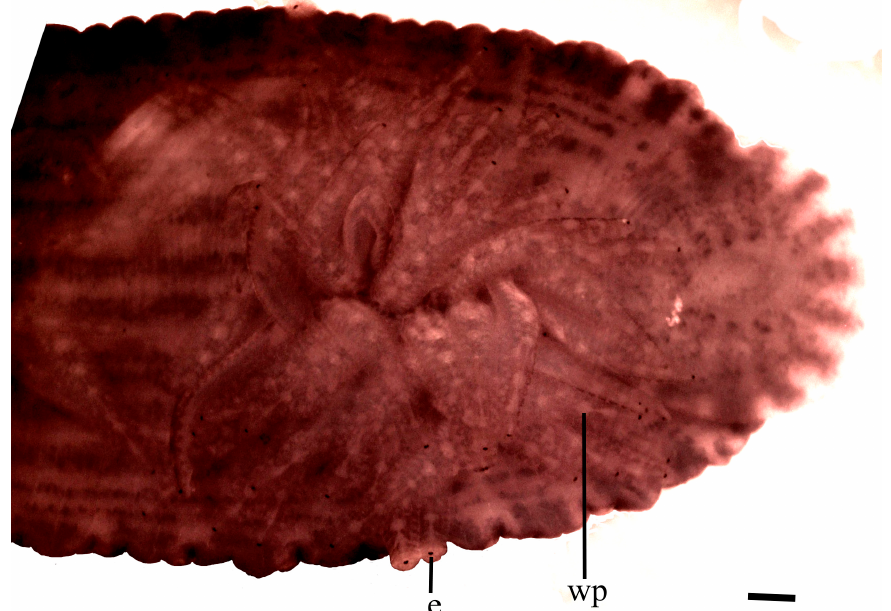
Figure 10. Recent hatchlings of P. parasitica from the Outer Banks more closely resemble adults of P. multilineata [9] (fig. 6A) than adults of their own species (Figure 1A). Shown are numerous hatchlings (PP-4b) brooded on the venter of the parent (PP-4a). Note each hatchling displays six discrete mid-dorsal white patches (see also Figures 11 and 12) barely recognisable in the adult (but see Figure 2C). Abbreviations: e, eye of hatchling; wp, white patch of hatchling. Scale bar: 1.0 mm. Tubercle obfuscation in P. parasitica versus prominence in P. multilineata . Of consid ‐ erable morphological significance, hatchlings of P. parasitica differ from adults in having small but distinct dorsal tubercles (Figure 11, tu). These are in longitudinal rows in inter ‐ mediate position on the a2 annulus in segments XIII–XXII, inclusively (Figure 12, tu). Fur ‐ thermore, these align near the respective tips of the underlying crop caeca, a feature seen in young and adult P. multilineata [9] (fig.15). In contrast, in adult P. parasitica tubercles are substantially obliterated or lacking altogether (Figure 2A,B). In younger, juvenile P. parasitica there are still some discernible tubercle ‐ like protuberances in intermediate posi ‐ tion on the a2 annulus in segments IX–XXIV, inclusively (Figure 2C, tu). Whereas the tubercles of P. parasitic become more indeterminate with age (Figure 1A), those of P. multilineata become more prominent (Figure 1B). This is interpreted as the first example of character displacement in the Hirudinea [26,27]. This reflects a significant taxonomic distinction between smooth and tuberculated turtle leeches throughout much of North America as discussed below. White pigment patches of hatchling P. parasitica and P. multilineata diverge during development. Hatchlings of P. parasitica invariable display six white pigment patches (Fig ‐ ure 10, wp) not discretely evident in the adult of this species. In hatchlings, these white patches are invariably centred at the midline at segments VIa3 (nuchal), IXa2 (pre ‐ genital),